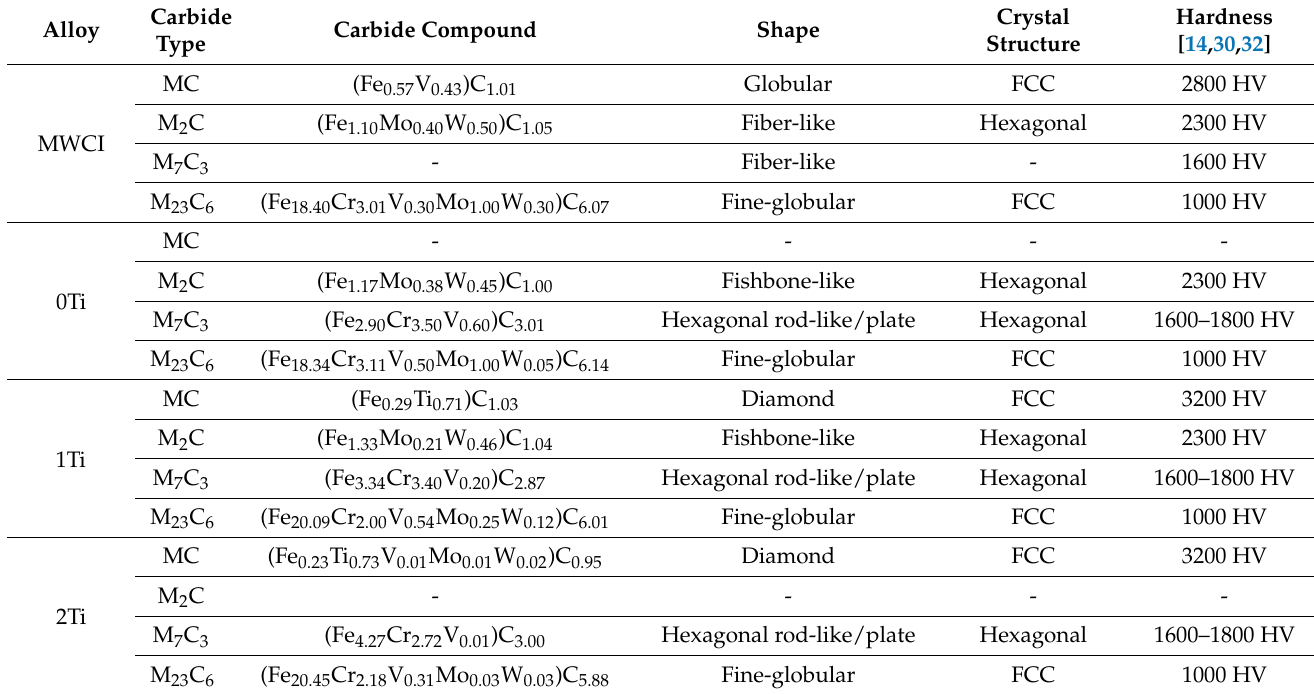
Table 2. Characteristics of precipitated